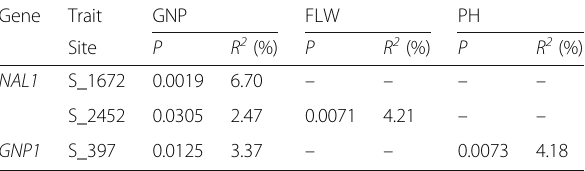
Table 1 Results of MLM association of SNPs extracted from the two genes ( NAL1 and GNP1 ) with traits in 198 accessions Gene